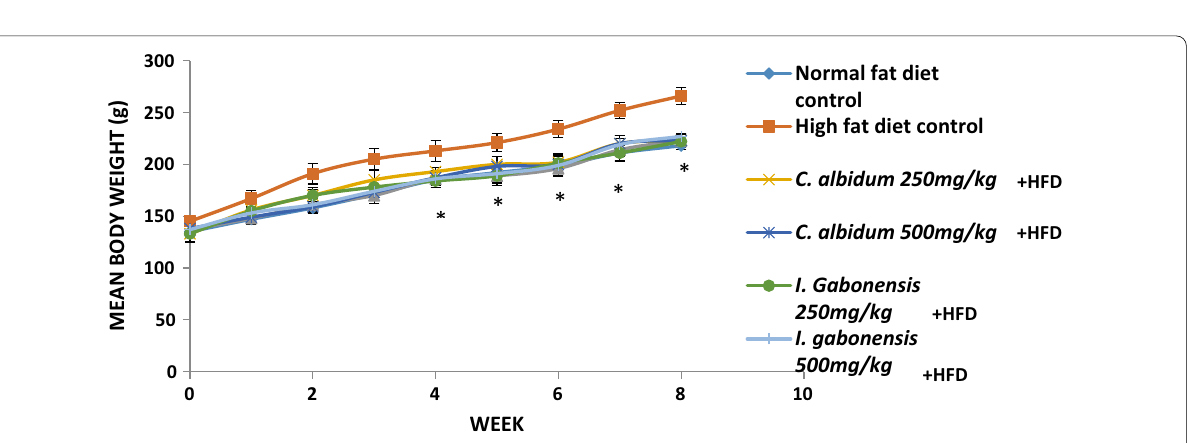
Fig. 2 Effect of C. albidum and I. gabonensis extracts on the weekly body weight of rats fed with HFD. Values are expressed as mean Points bearing asterisk * Extracts and NFD control are significantly different from HFD control. At weeks 0, 1, 2 and 3 there was no significant = difference ( p > 0.05) in the body weights of all groups. However, from week 4 to 8 the body weight of rats in HFD control was significantly higher ( p ˂ 0.05) than the body weights of rats in the extracts treated groups and NFD